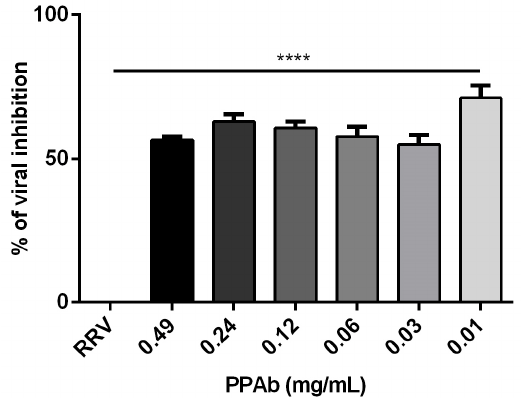
Figure 3. Reduction of infectious rotavirus yield post-infection exerted by the PPAb. MA104 cells were incubated with RV (RRV, MOI = 0.1) for 1 h to facilitate viral adsorption. The viral inocula were removed and replaced with culture medium without FBS and different concentrations of the PPAb. Cells were incubated 24 h to verify viral replication. Then, viral particles were harvested, and infectious FFU units (FFU) were quantified by ICC as described in Figure 2. RRV: RV-infected cells. All experiments were done in triplicates and repeated independently three times. Bars represent mean ± SD., **** p < 0.0001; unpaired Welch’s t -test for comparisons with the control of RRV-infected cells.